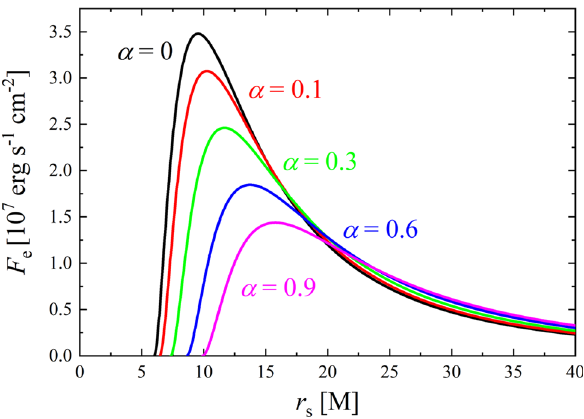
Fig. 8 The radiation flux F e from the thin accretion disk around Schwarzschild-MOG BHs under different α as a function of disk ele- ment’s radius r s . Here, the BH mass and accretion rate are, respectively, 10 6 M (cid:9) and 10 − 12 M (cid:9) /